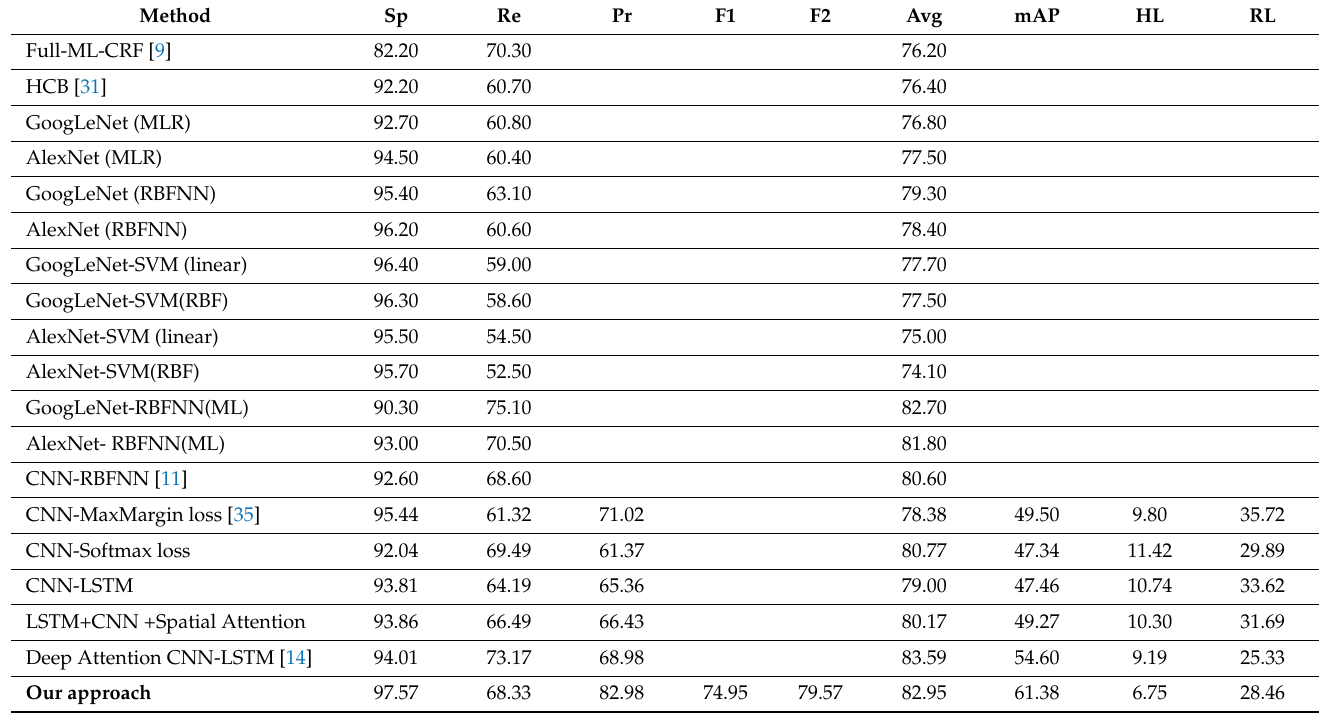
Table 6. Results of the Trento multi-label dataset.